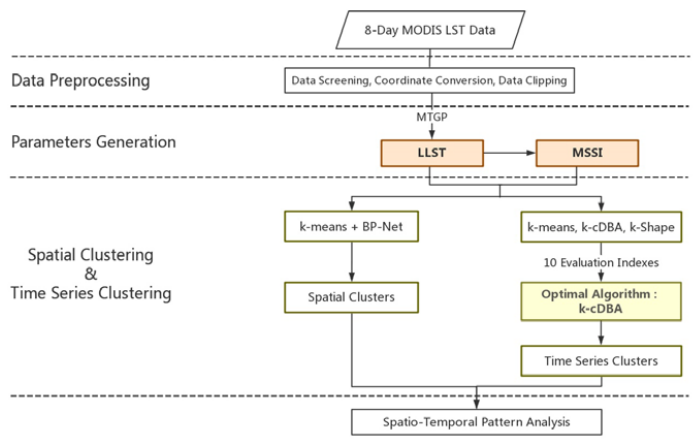
Figure 3. The representation of the methodological framework used in this study.